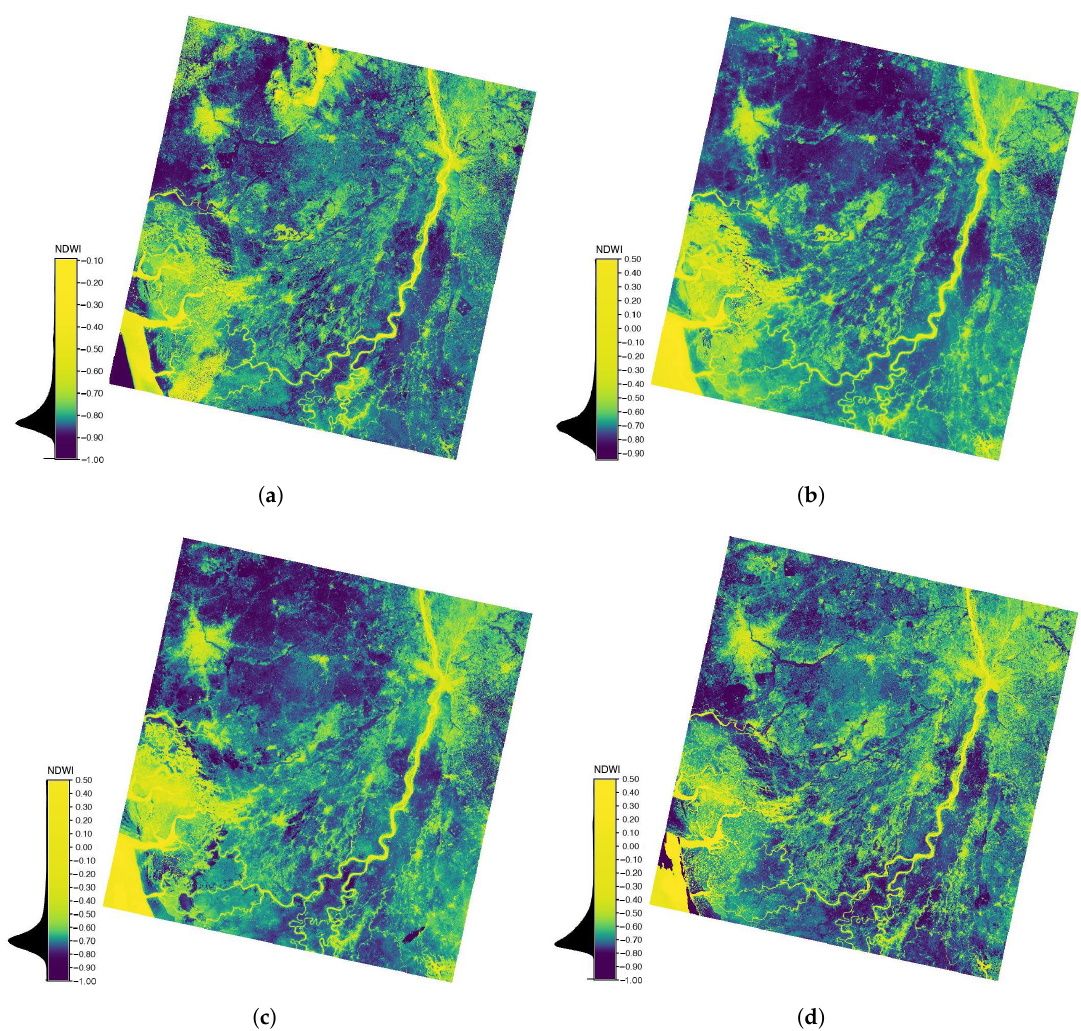
Figure 9. NDWI computed from the Landsat 8-9 OLI/TIRS images of Niger River Delta for four years: ( a ) 2013, ( b ) 2015 ( c ) 2021, ( d )